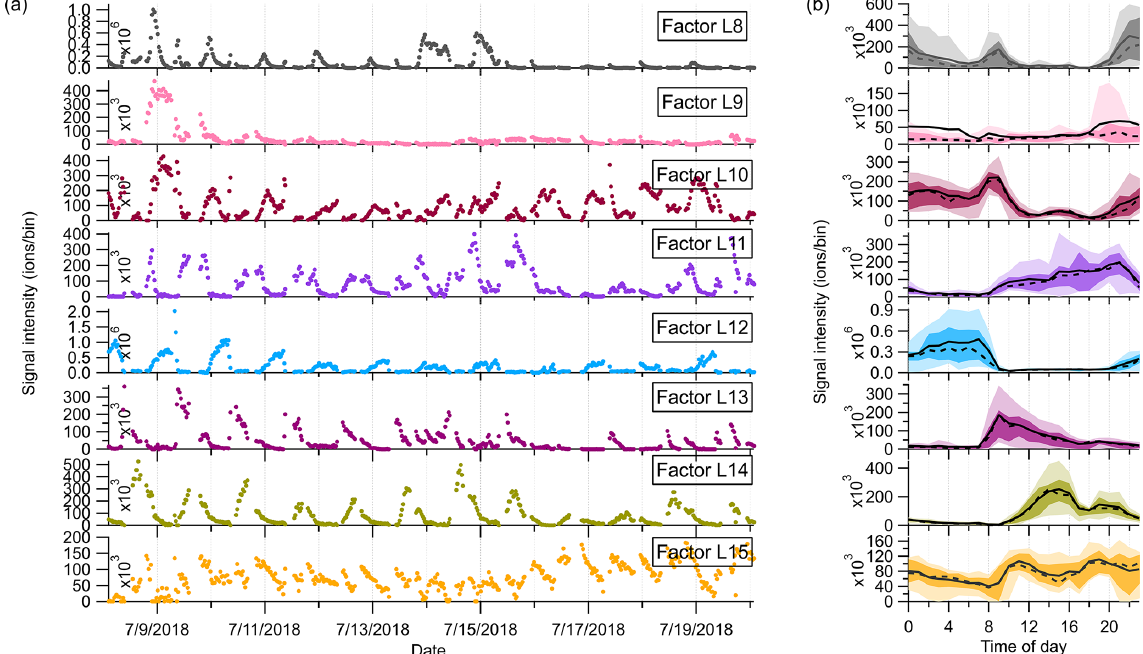
Figure 6. (a) Time series and (b) diurnal trends of the eight factors resolved in the high-mass range in the Landes forest. The solid and dashed lines in the diurnal plots show the mean and median values, respectively, and the shaded area shows 10th, 25th, 75th, and 90th